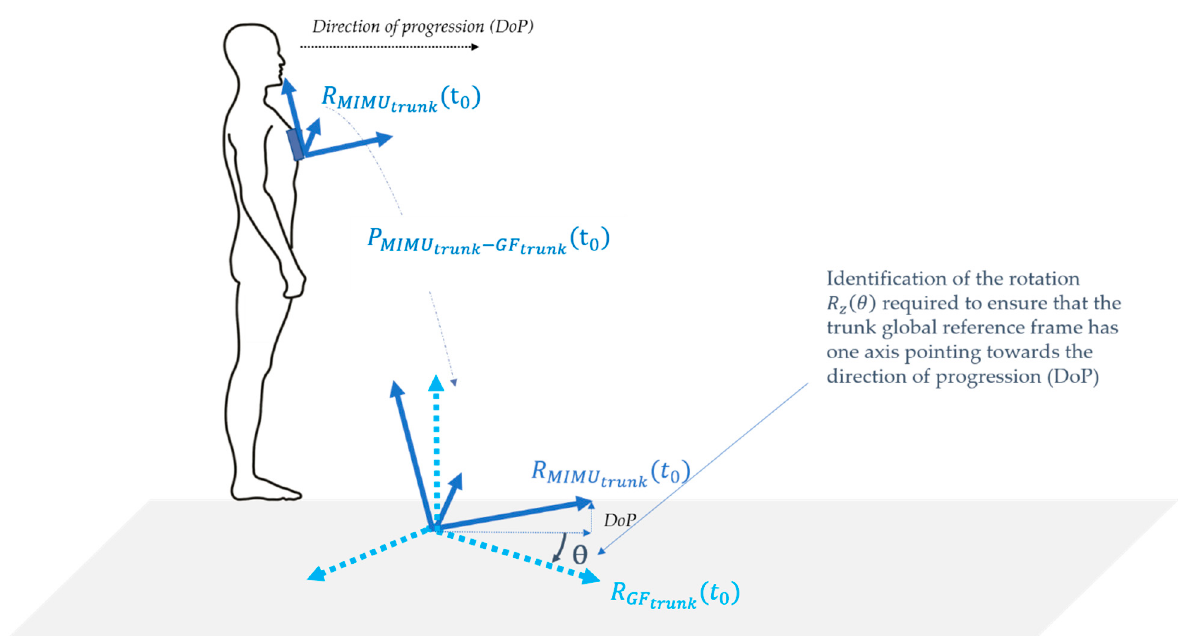
) to align one of its axes with the direction of (cid:3295)(cid:3293)(cid:3296)(cid:3289)(cid:3286) trunk ).